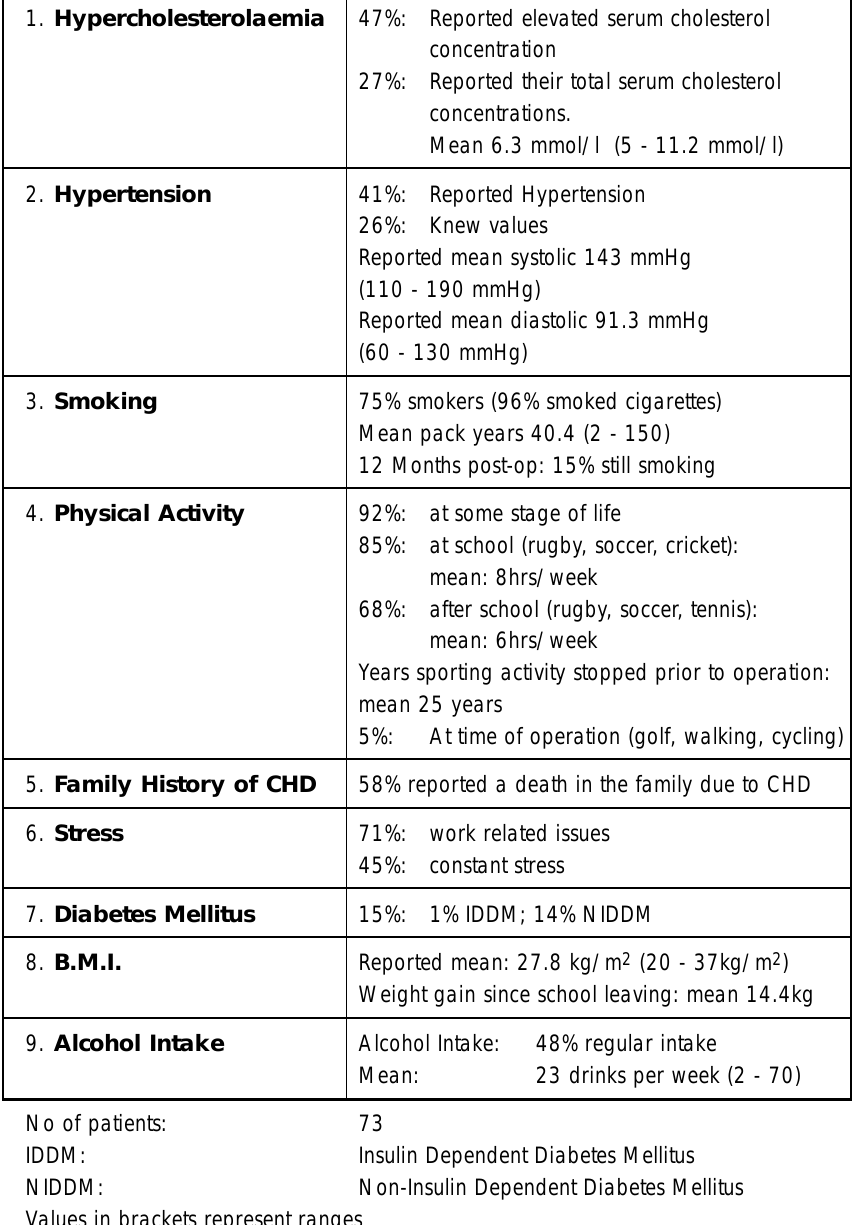
Table 11: Risk Factor Profile.